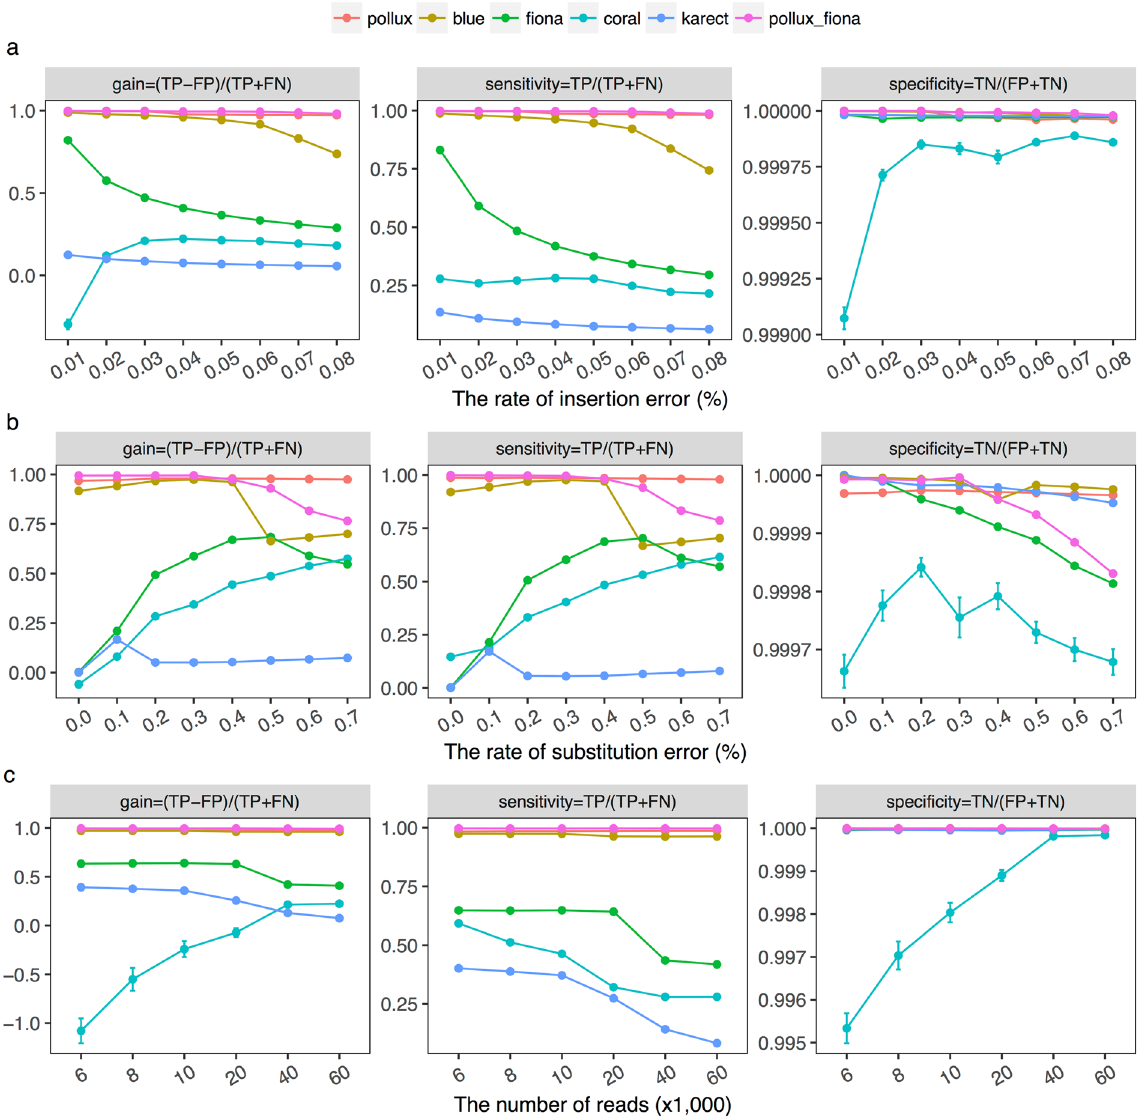
Figure 5. Error correction performance in the simulated PGM data. ( a ) A model of indel errors. We assumed a fixed substitution rate (0.17%) and read number (60,000) with varied indel error rates, and the deletion error rate was 1.5 times the insertion error rate. ( b ) A model of substitution errors. We assumed a fixed insertion (0.04%) and deletion (0.06%) error rate and read number (60,000) with varied substitution error rates; and ( c ). A model of sequencing depth. We assumed fixed insertion (0.04%) and deletion (0.06%) error rates and substitution error rates (0.17%) with different sequencing